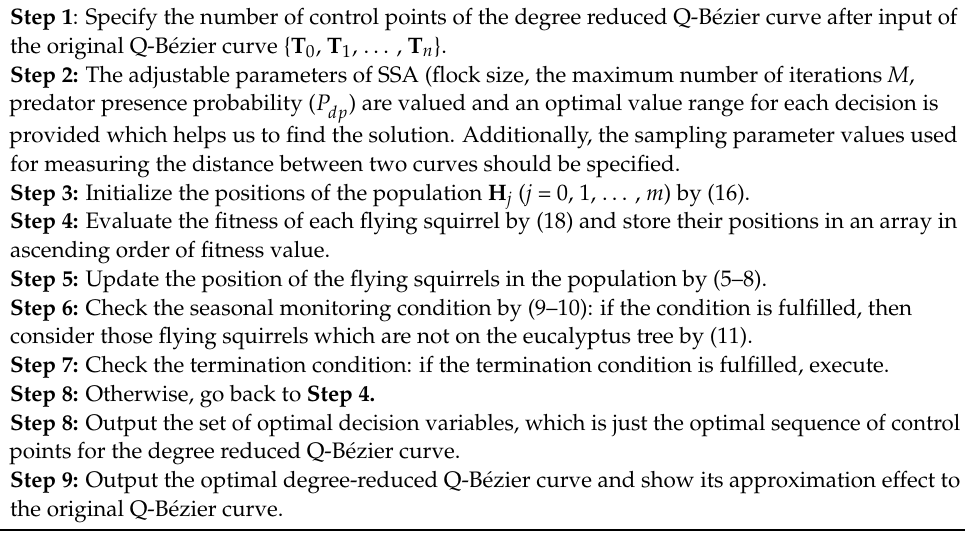
Algorithm 1 Squirrel search algorithm: steps to SSA-based degree reduction of Q-B é zier